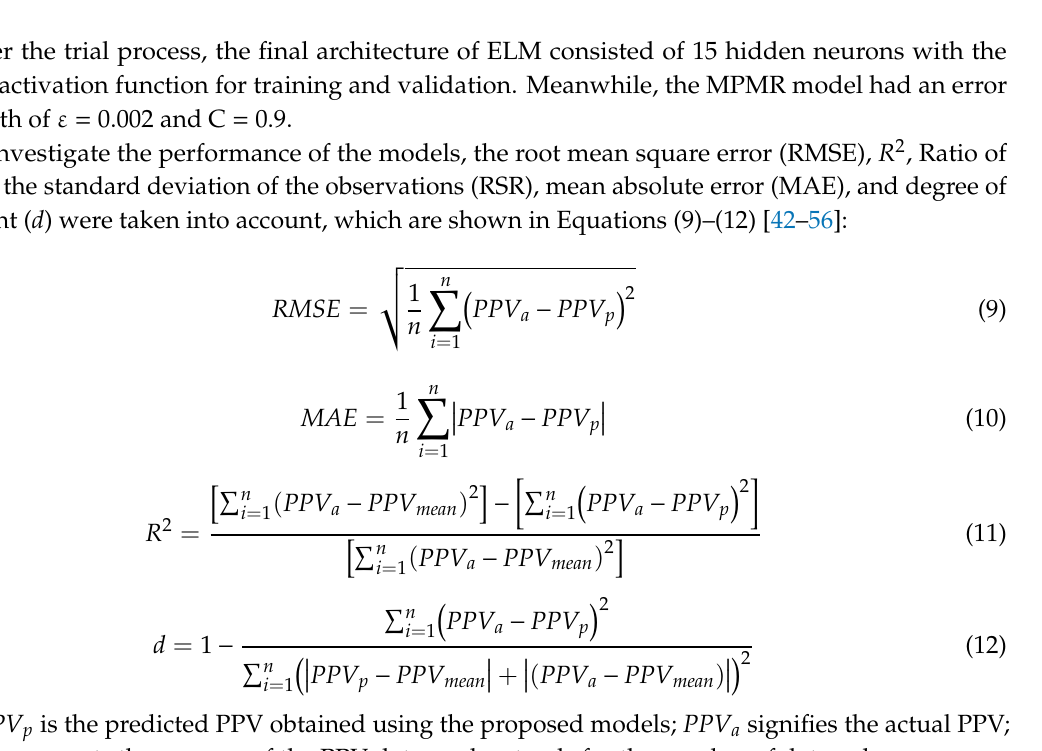
Table 5. Testing the di ff erent values of number of habitats with their R 2 . Model No. Number of Habitats